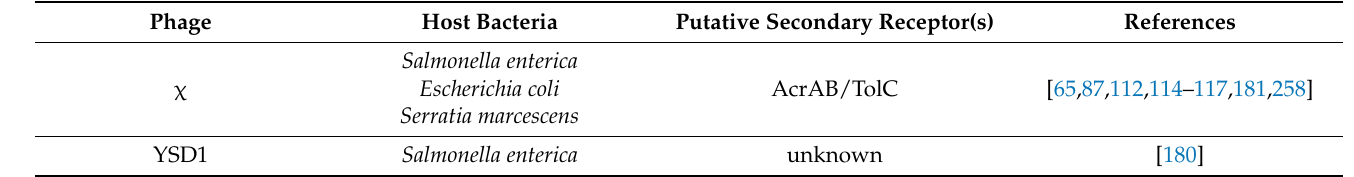
Table 1. Flagellotropic phages, verified hosts, and putative secondary receptors. The primary receptor of all the phages listed is the flagellum. Phages are ordered based on their similarity and relative depth of